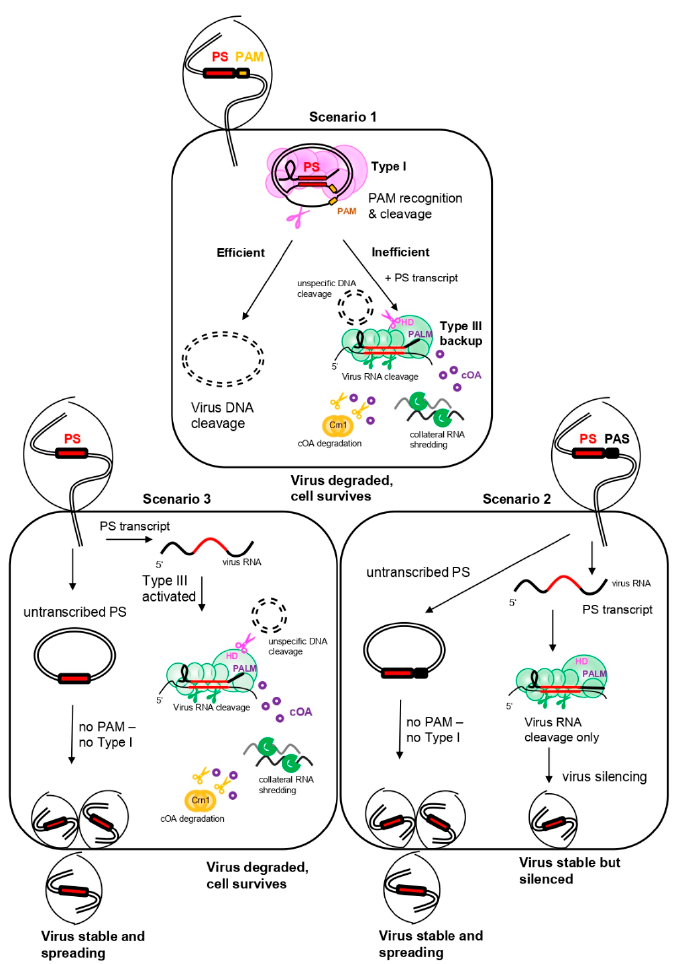
Figure 6. Three scenarios of anti-virus immunity in a Sulfolobales cell. Scenario 1 (PAM) would be the most e ffi cient to degrade a virus in a Sulfolobales cell, whereas scenario 3 (no PAM, no PAS) could lead to virus spreading and / or cell death. Scenario 2 (PAS) is the only scenario that could lead to virus silencing on RNA level and, consequently, persistence of the virus in the